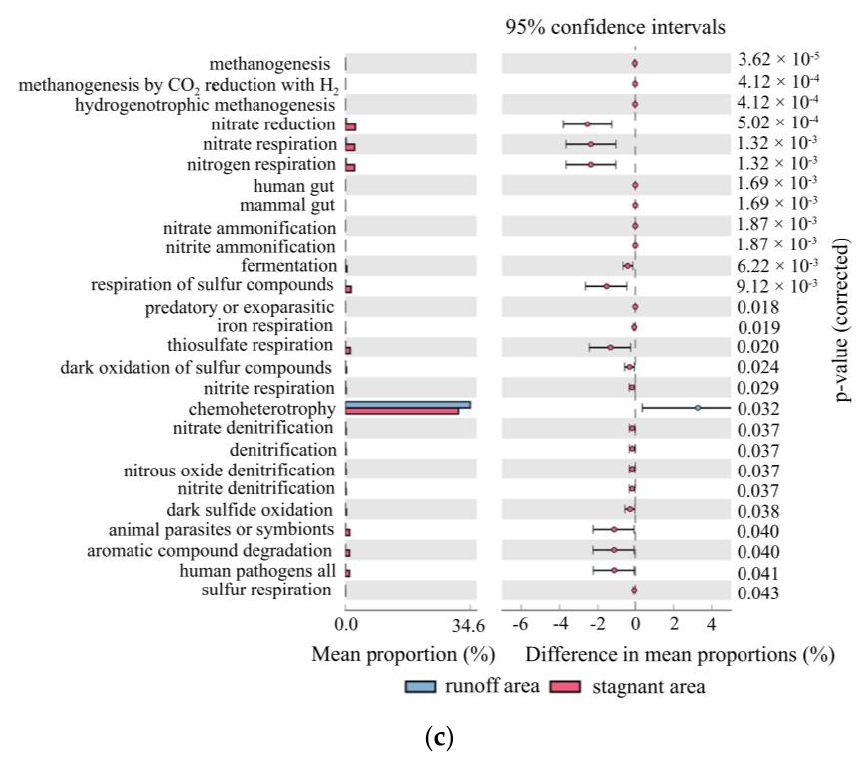
Figure 8. ( a ) Heatmap showing relative abundance of C-N-S microorganisms of each sample in runoff and stagnant areas. The relative abundance of microorganisms was converted into a log 10 (relative abundance × 10 6 ) scale for better exhibition in the heatmap. ( b ) Comparison of C-N-S microorganisms between runoff and stagnant areas. The relative abundance of genes was converted into a log 10 (relative abundance × 10 6 ) scale for better exhibition. ( c ) Analysis of different relative abundances of C-N-S microorganisms between runoff and stagnant areas using Welch’s t -test with FDR correction in STAMP (95% confidence intervals, p < 0.05).